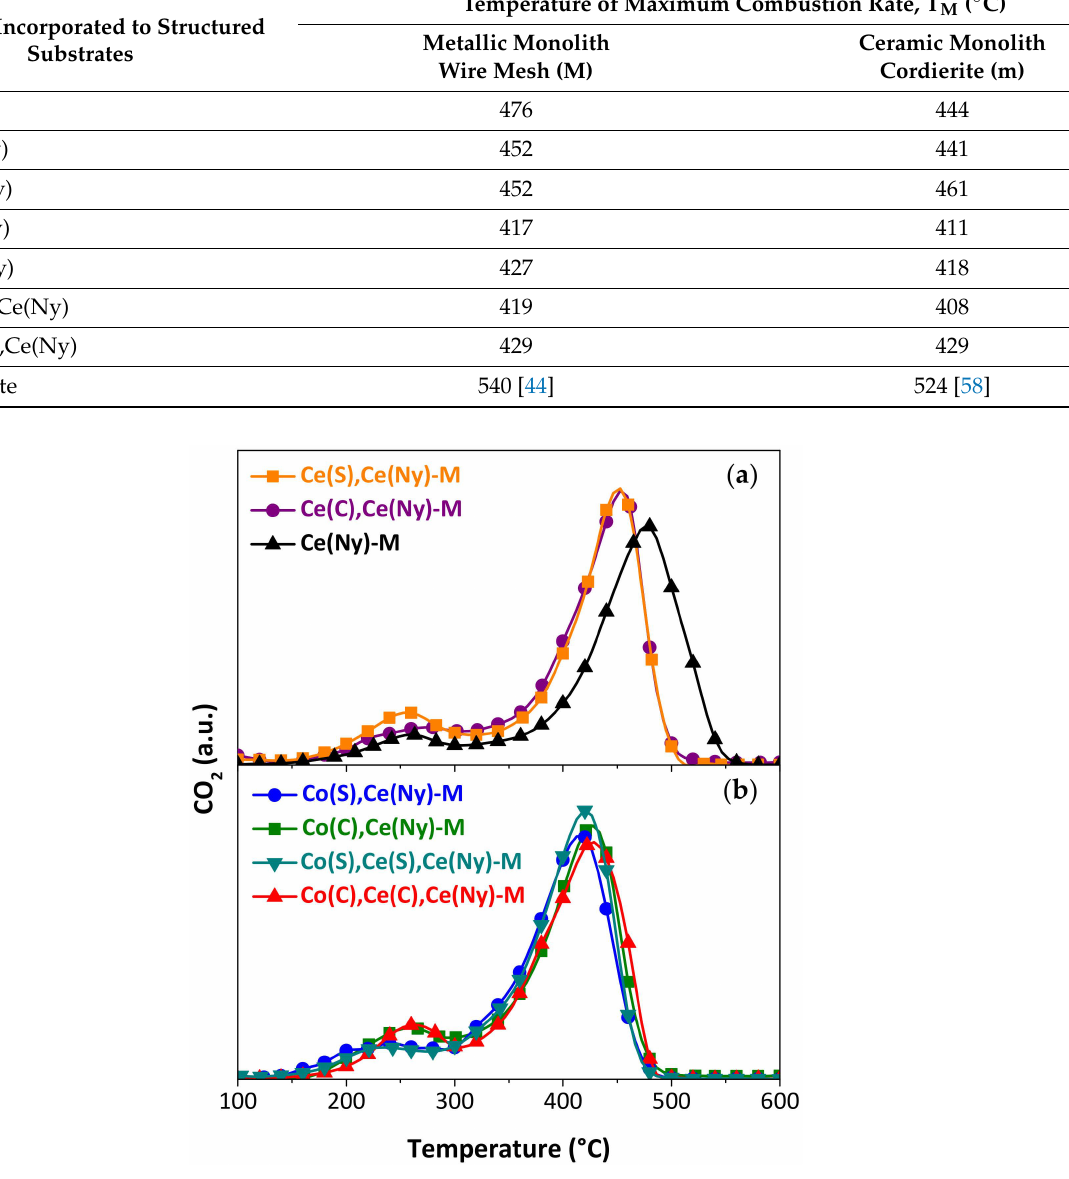
Figure 7. TPO profiles obtained for the burning of diesel soot from catalytic cordierite monoliths: ( a ) CeO 2 and ( b ) Co,Ce